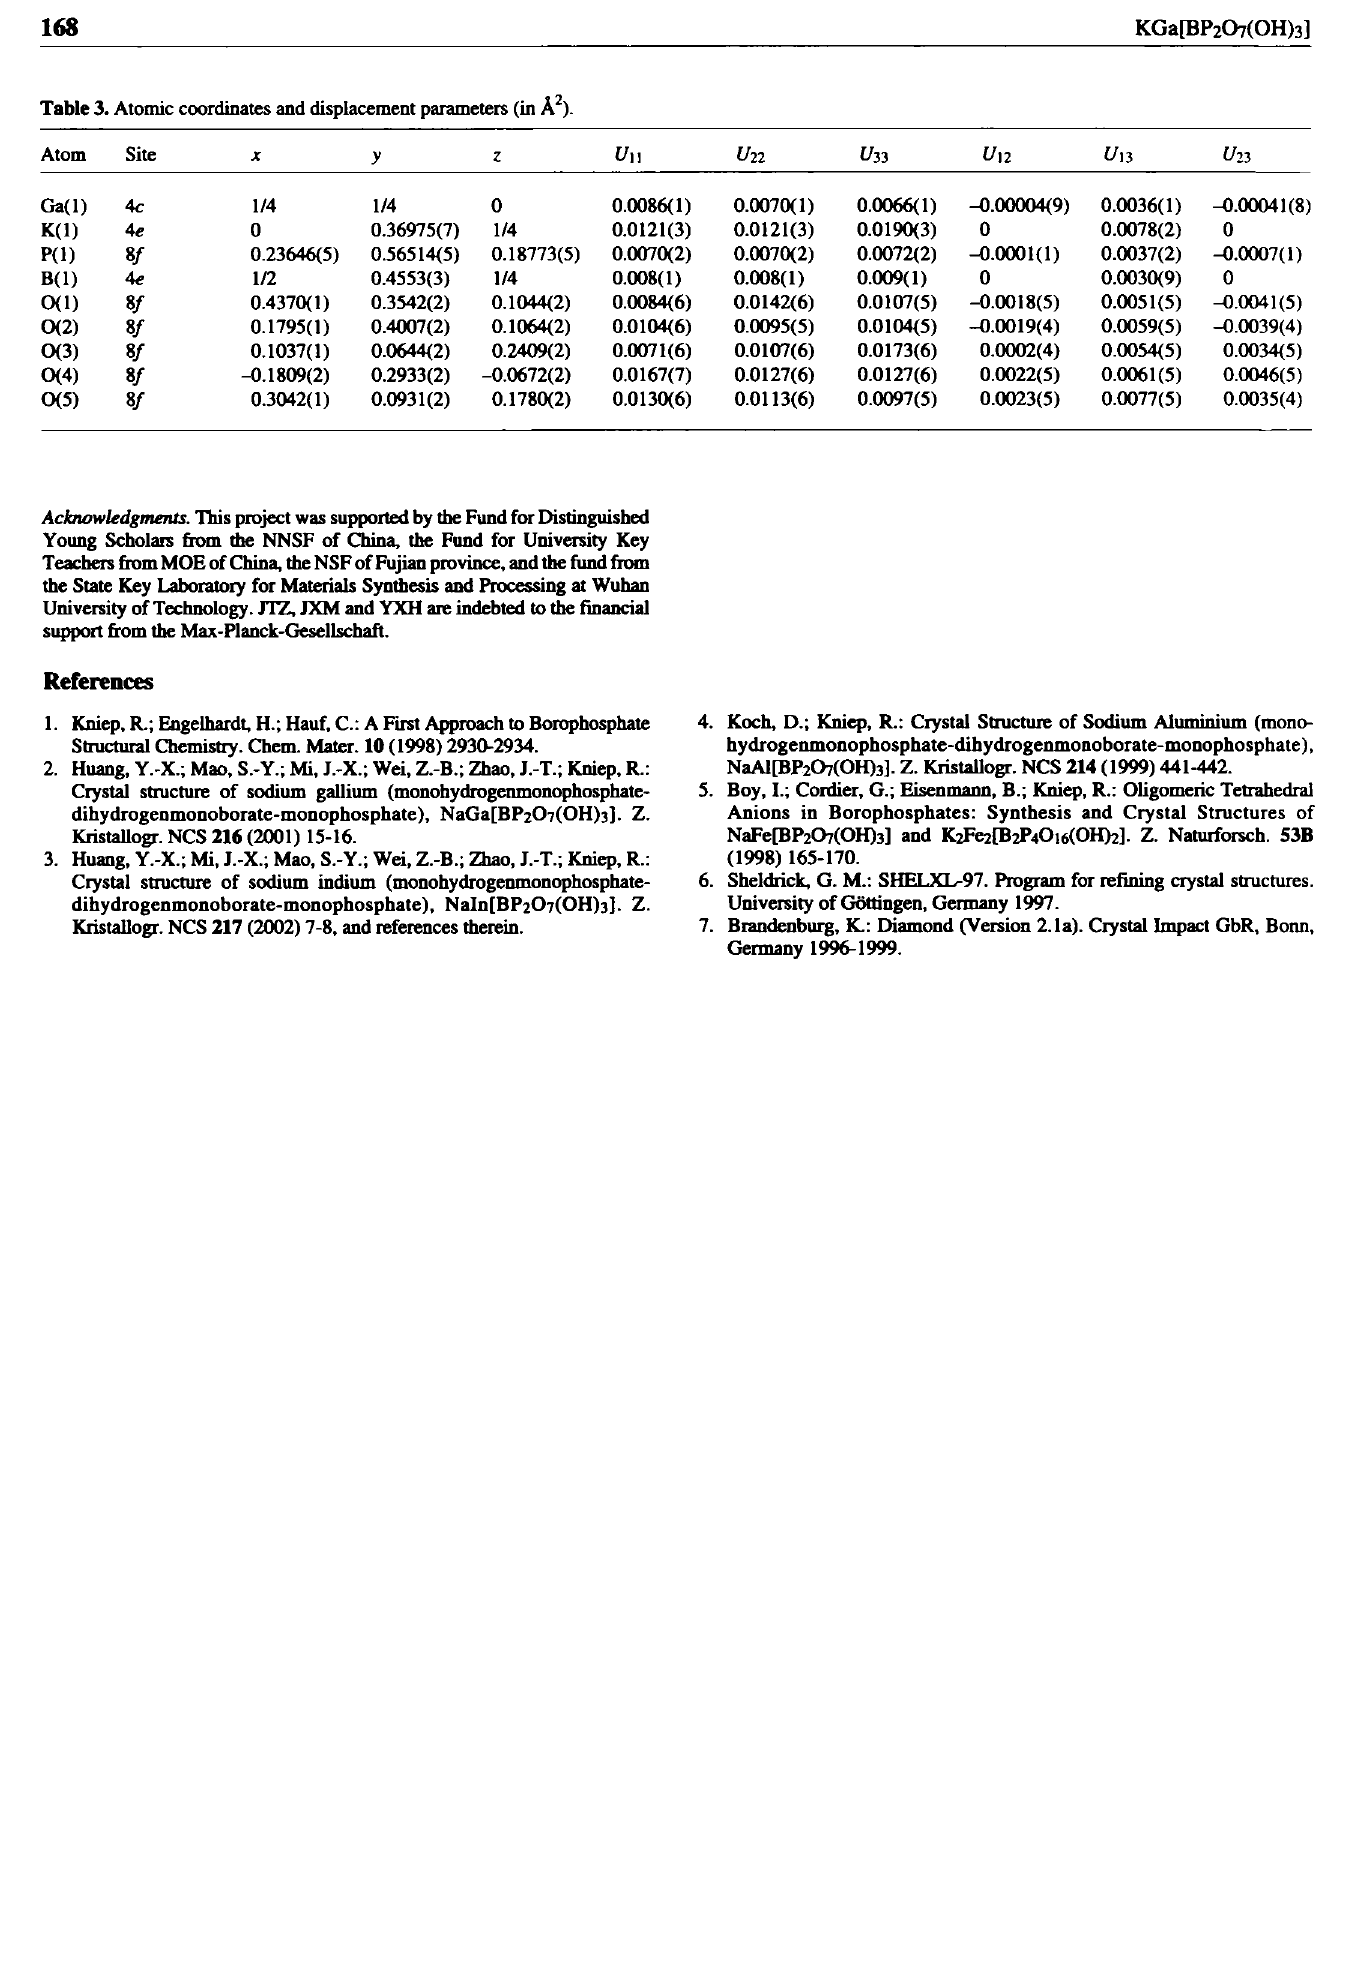
Table 3. Atomic coordinates and displacement parameters (in Â 2